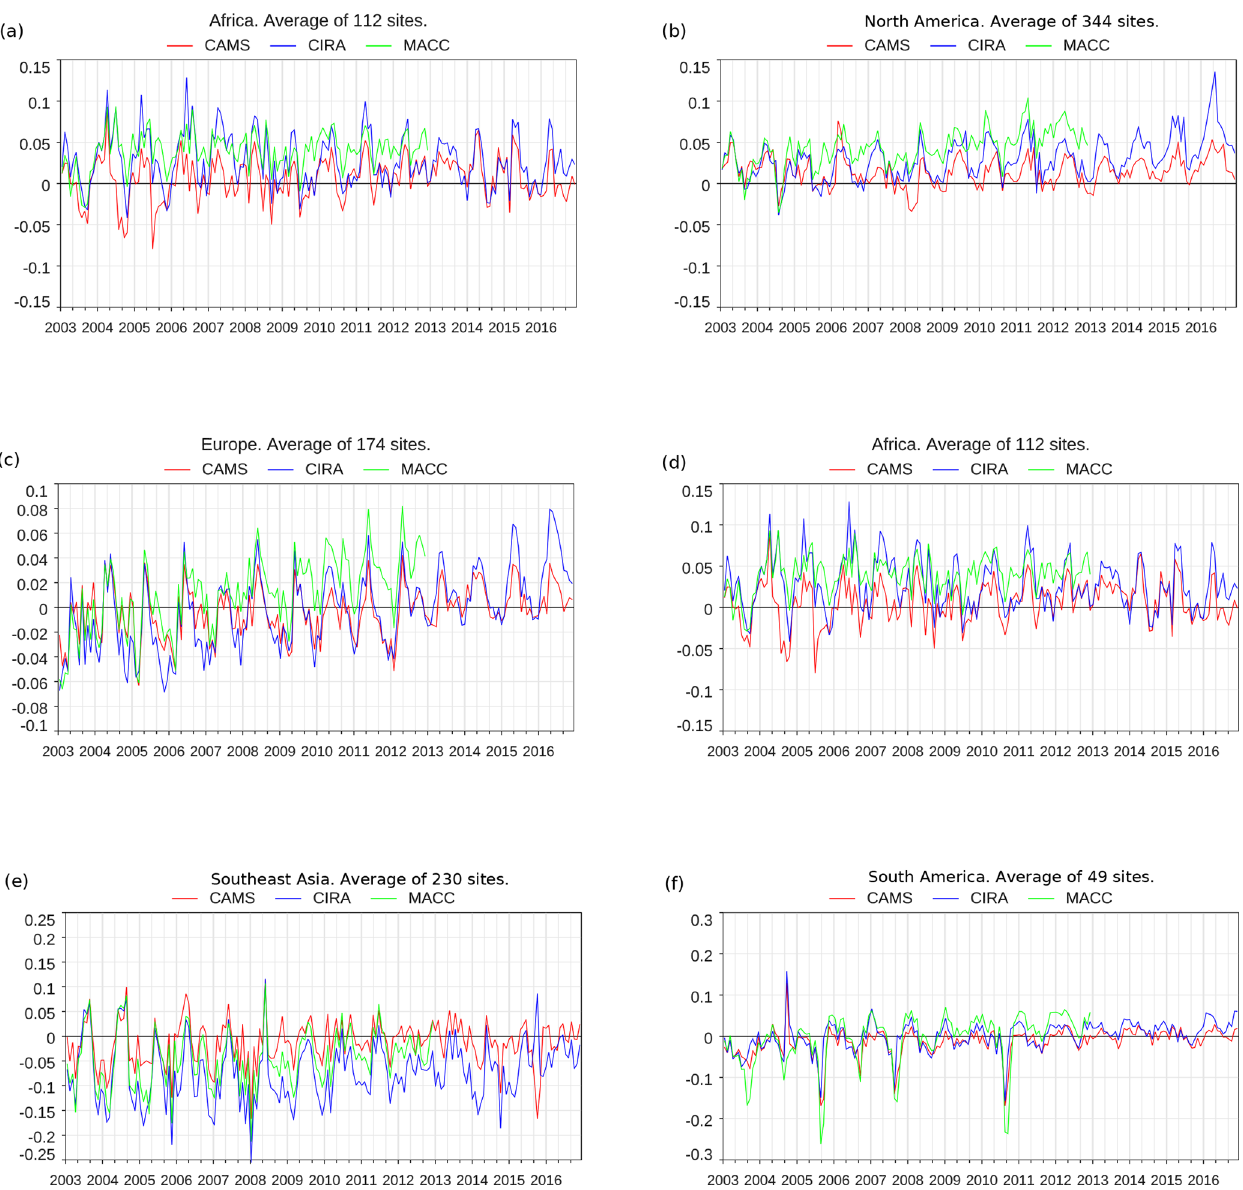
Figure 22. Time series of monthly mean bias of total AOD from the reanalyses against AERONET V3 Level 2.0 observations for the following areas: (a) globe, (b) North America, (c) Europe, (d) Africa, (e) Southeast Asia and (f) South America. CAMSRA is shown in red, CIRA in blue and MACCRA in green. Mauna Loa and Mexico City were excluded from these time series, as they are unrepresentative and skew the statistics. AOD is